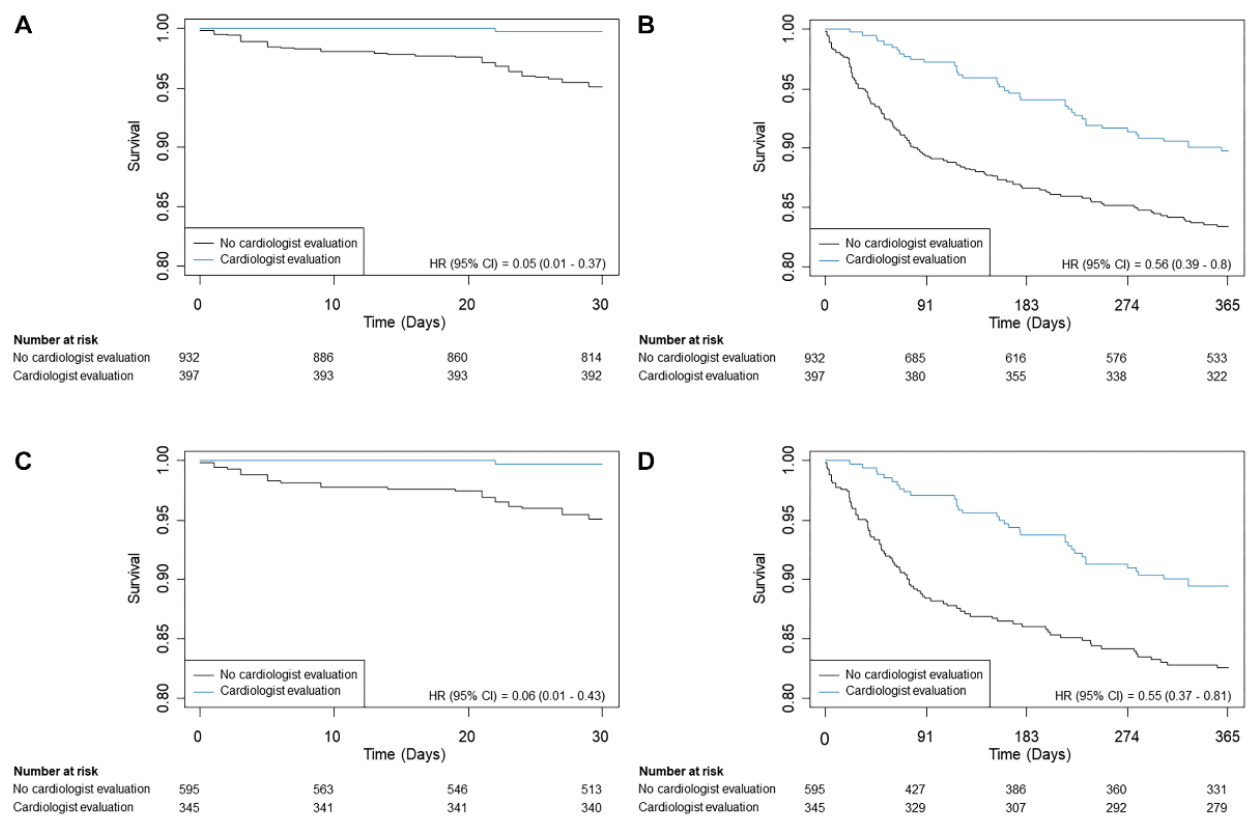
Figure 1. Kaplan–Meier curves of all-cause mortality in the ( A ) 30-day and ( B ) one-year mortalities for the entire popula- tion; and ( C ) 30-day and ( D ) one-year mortalities for the propensity-score matched population.